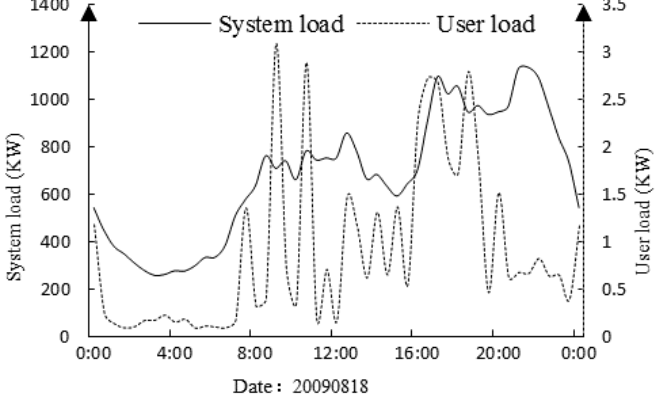
Figure 1. Load curves of the system and one domestic user on 18 August 2009.